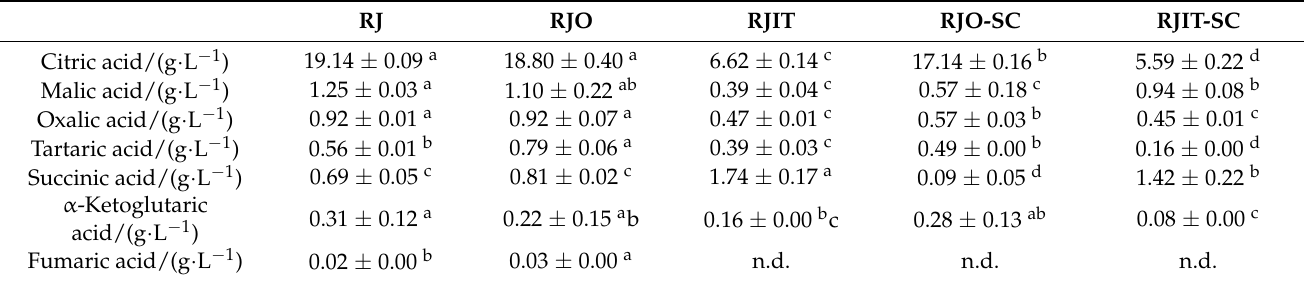
Table 2. Effect of I. terricola WJL-G4 on organic acids contents of red raspberry wines. RJ